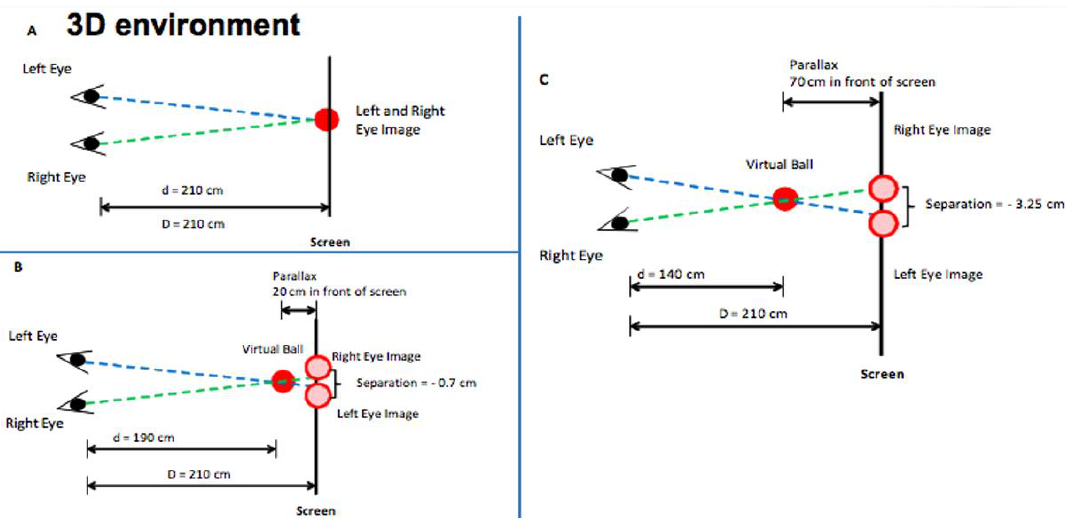
Figure 3. An illustration of the horizontal separation of two images on a 3D TV with three different levels of depth [5] .